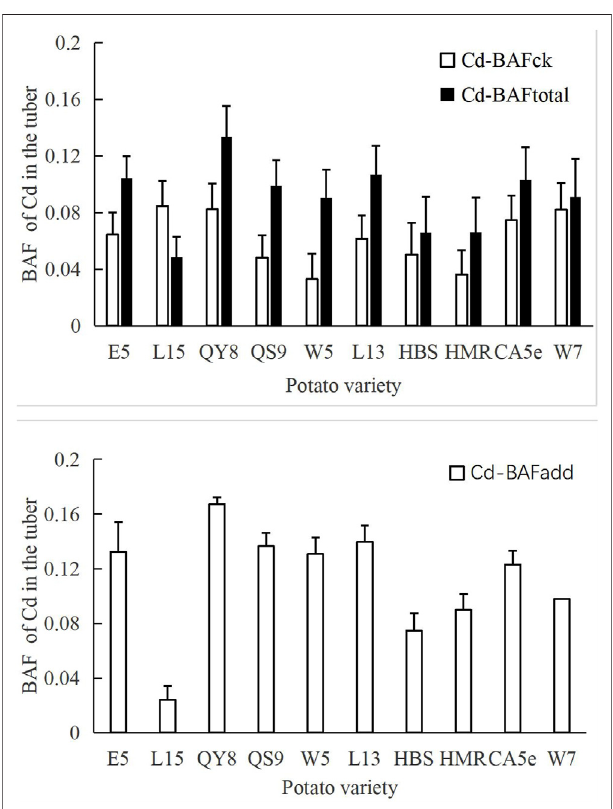
FIGURE 2 | BAF ck , BAF total and BAF add for different potato varieties in Guiyang soil.